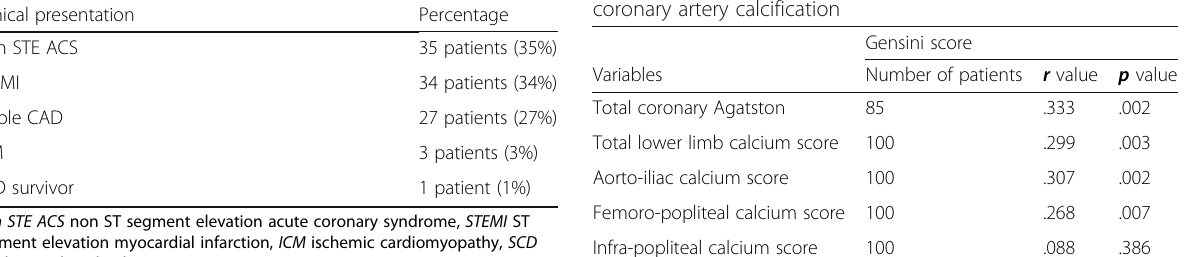
Table 4 Correlation of Gensini score to lower limb